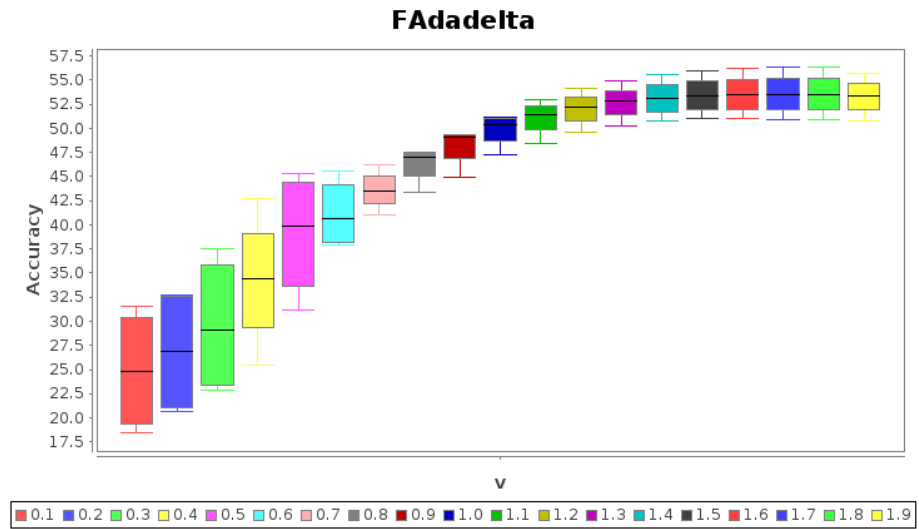
Figure 14. Experiment 3.1: FAdadelta cross-folding accuracies, K = 4 folds, ν ∈ [ 0.1,1.9 ] .